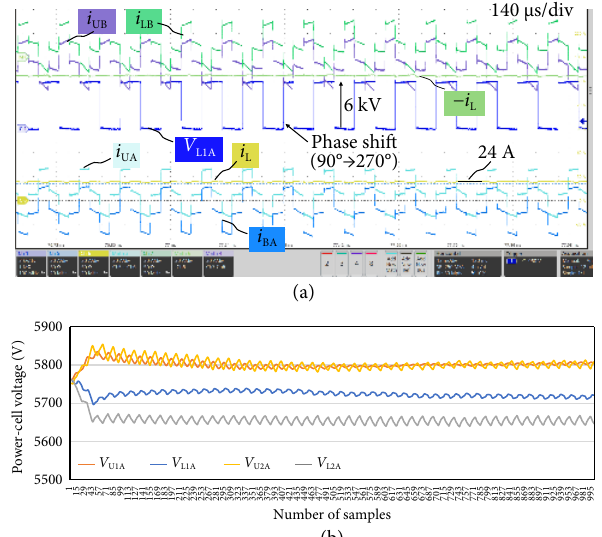
Fig. 16 (a) ICBT dc-ac operation mode having 12 kV dc-link with variable duty cycle, i L = 26 A. (b) Power-cell voltages collected through communication network and displayed on